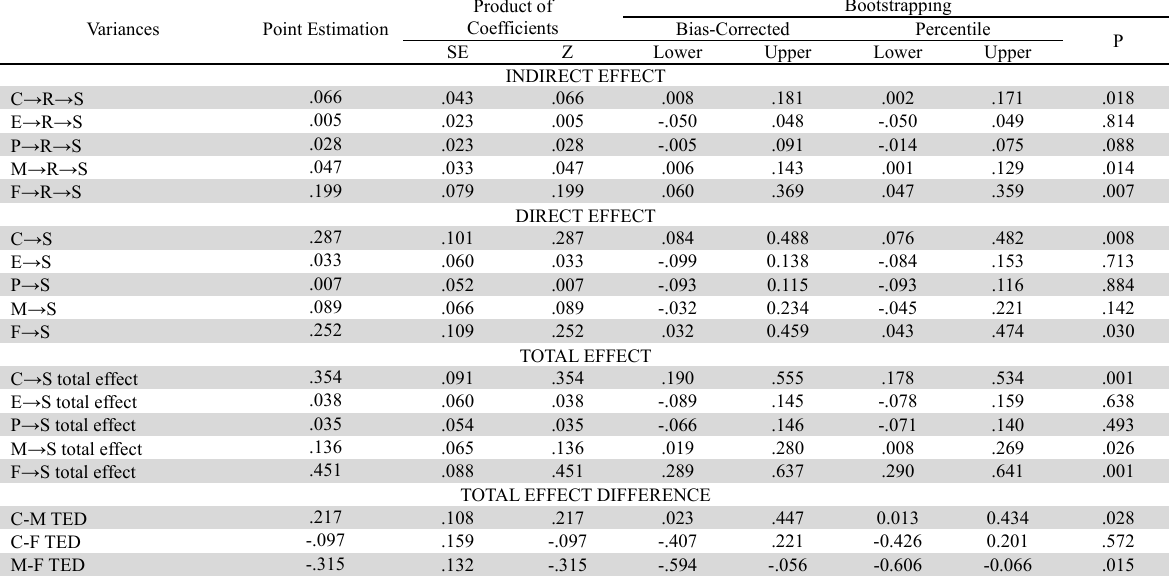
Effect of PDRQs on satisfaction Variances Point